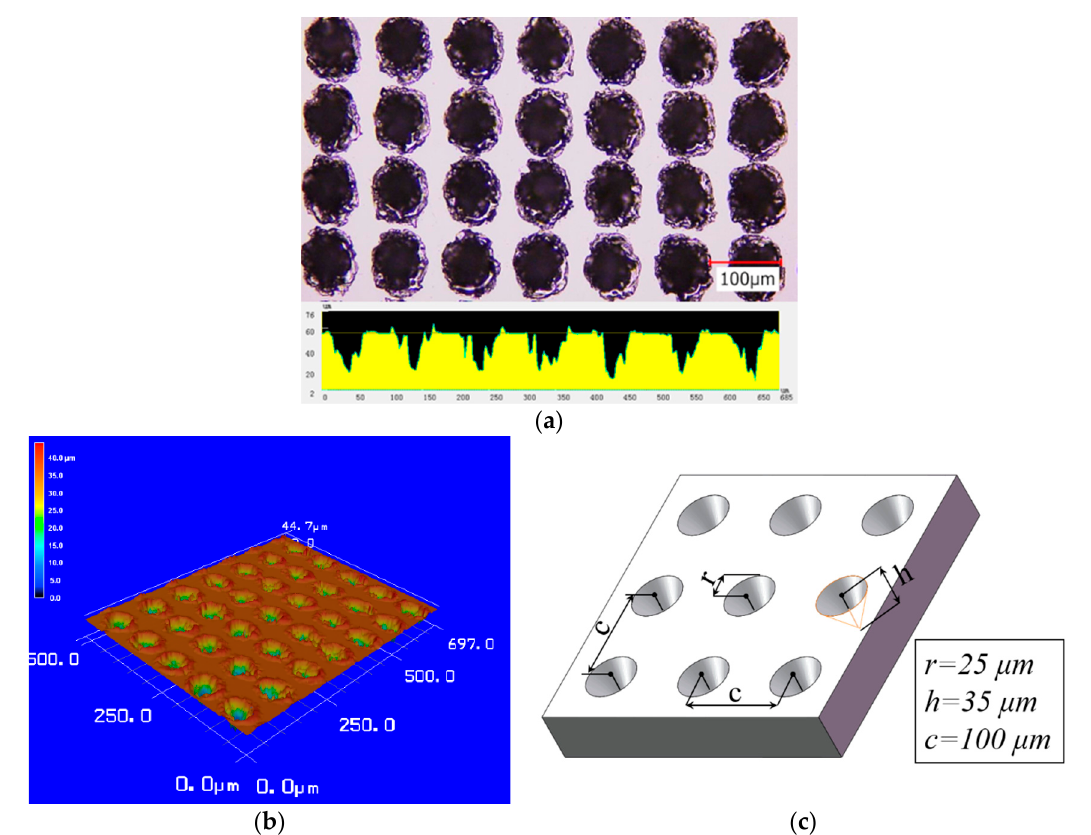
Figure 1. ( a ) Two-dimensional (2D) and ( b ) three-dimensional (3D) optical micrographs of the textured surface; ( c ) schematic of 3D